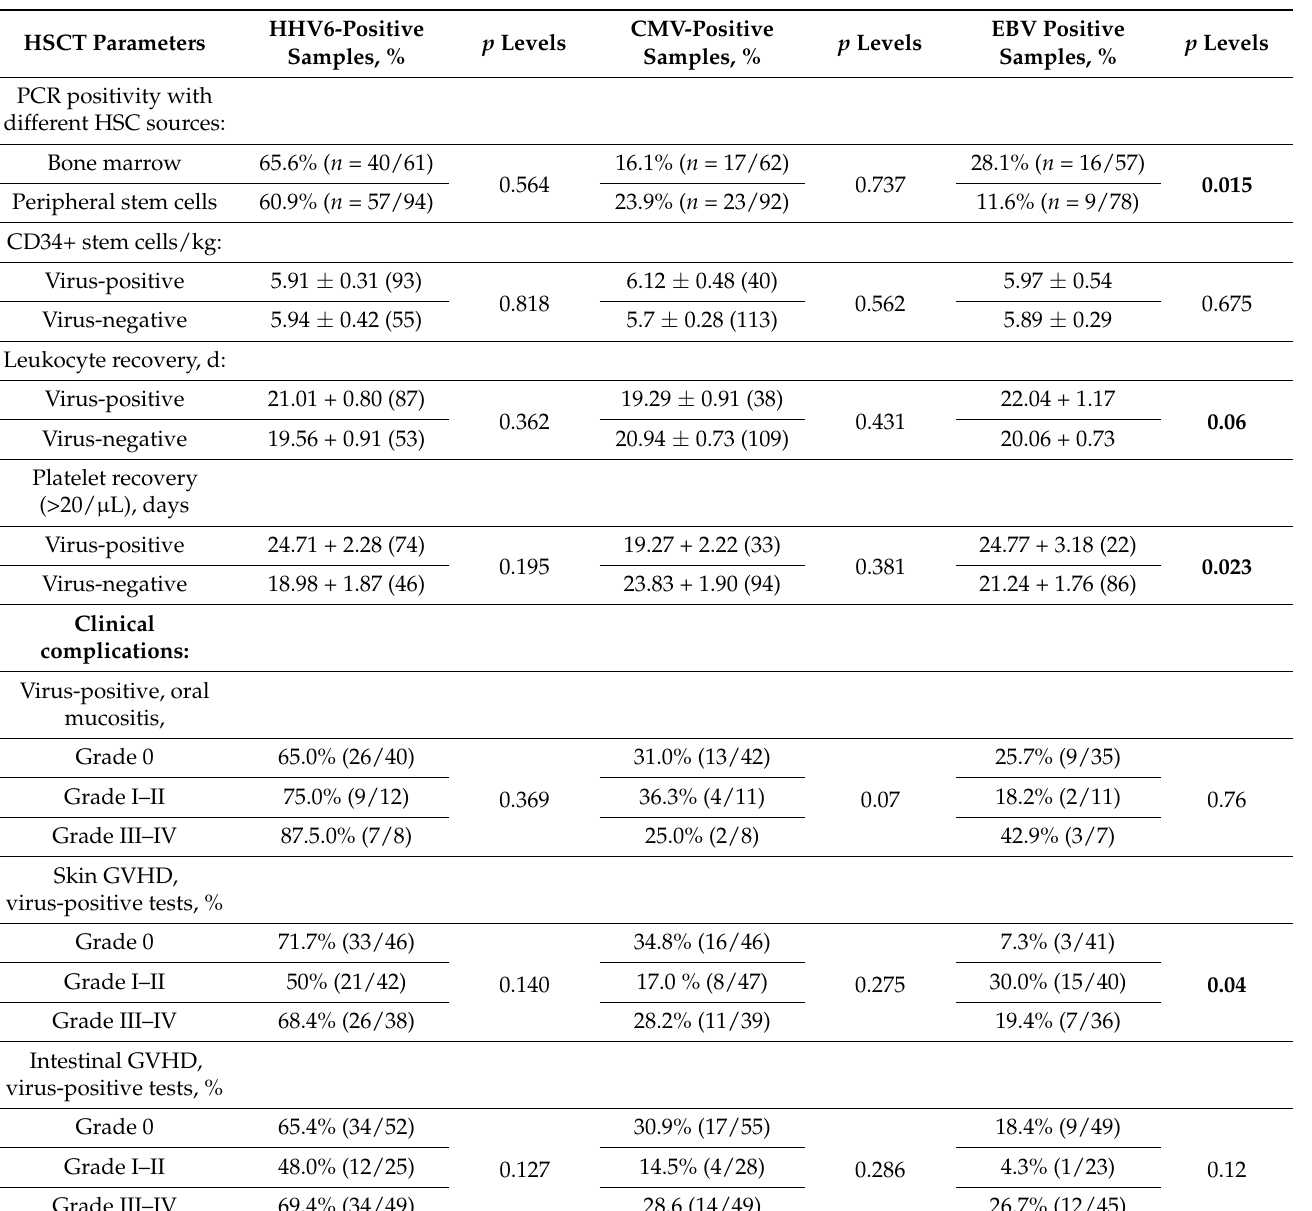
Table 2. Relative frequency of the three herpesviruses in the series of large bowel biopsies: depen- dence on the parameters and complications of HSCT (in parentheses, number of